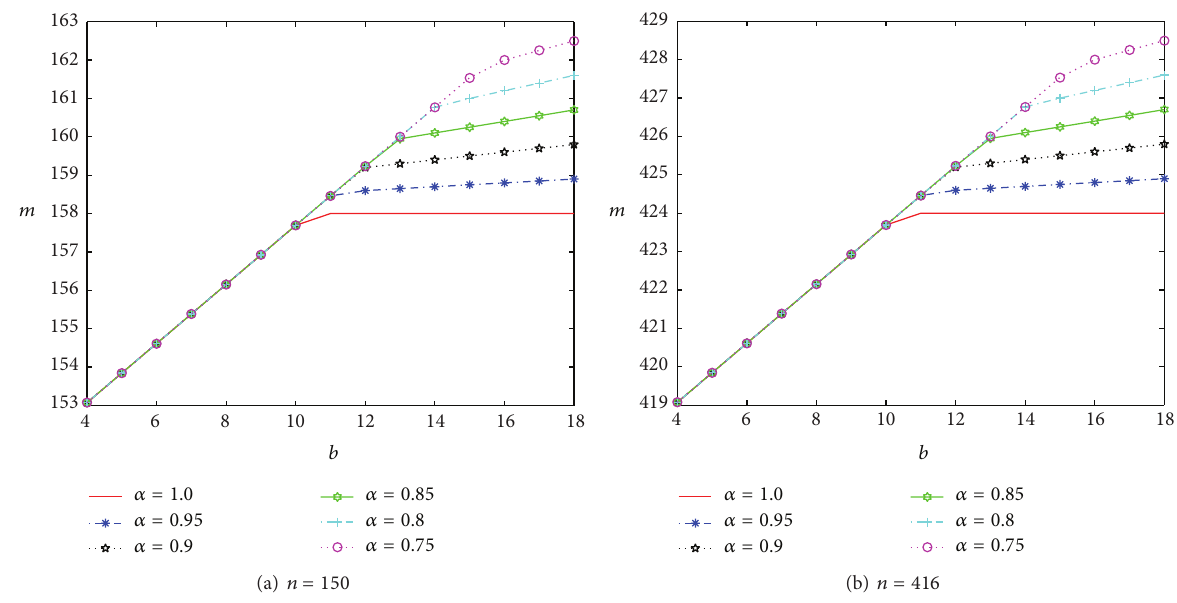
Figure 4: Optimal booking limit 𝑚 ∗ under the changes of 𝛼 and 𝑏 when 𝛽 = 0.8, 𝑗 = 8